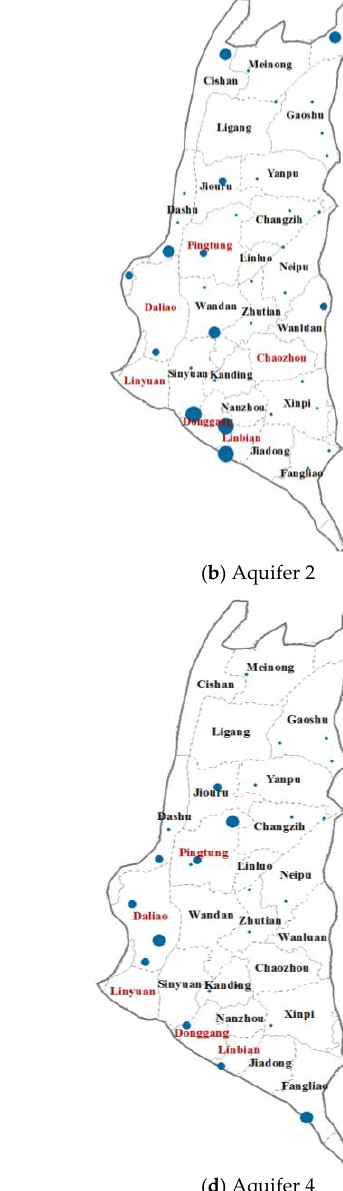
Figure 4. Measured arsenic concentration at the monitoring wells established by Taiwan’s WRA.